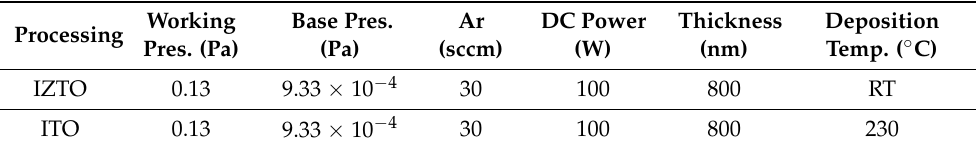
Figure 1. The typical structure of the electrochromic device for coloration states. Table 1. Details of the parameters of IZTO and ITO films.